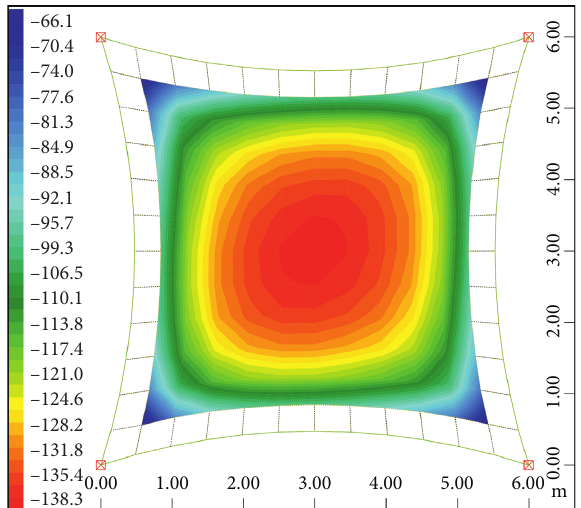
Figure 5: Possible maximal membrane deflections of the initial model in global Z direction for different positions of the 1kN point load (mm).